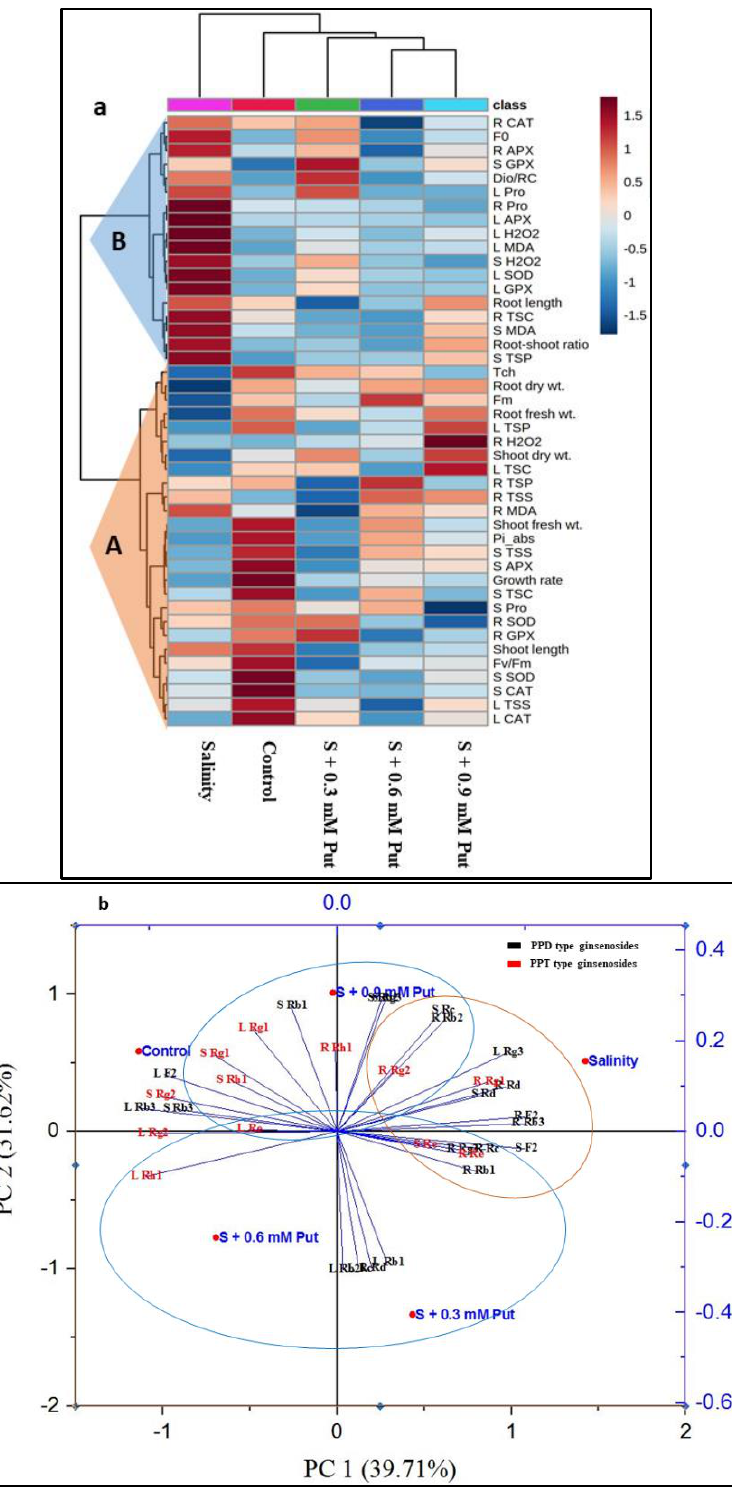
Figure 7. Hierarchical clustering and heatmap analysis ( a ), and principal component analysis (PCA) ( b ) to elucidate the variable treatment relationships under five treatments for 5 days. In the heatmap, the mean values of the various parameters obtained in this study were normalized and clustered. At the variable level, four separate clusters were recognized for each treatment. The color scale displays the intensity of normalized mean values of different parameters. In PCA, the lines starting from the central point of the biplots display negative or positive associations of different variables, and their proximity specifies the degree of correlation with specific